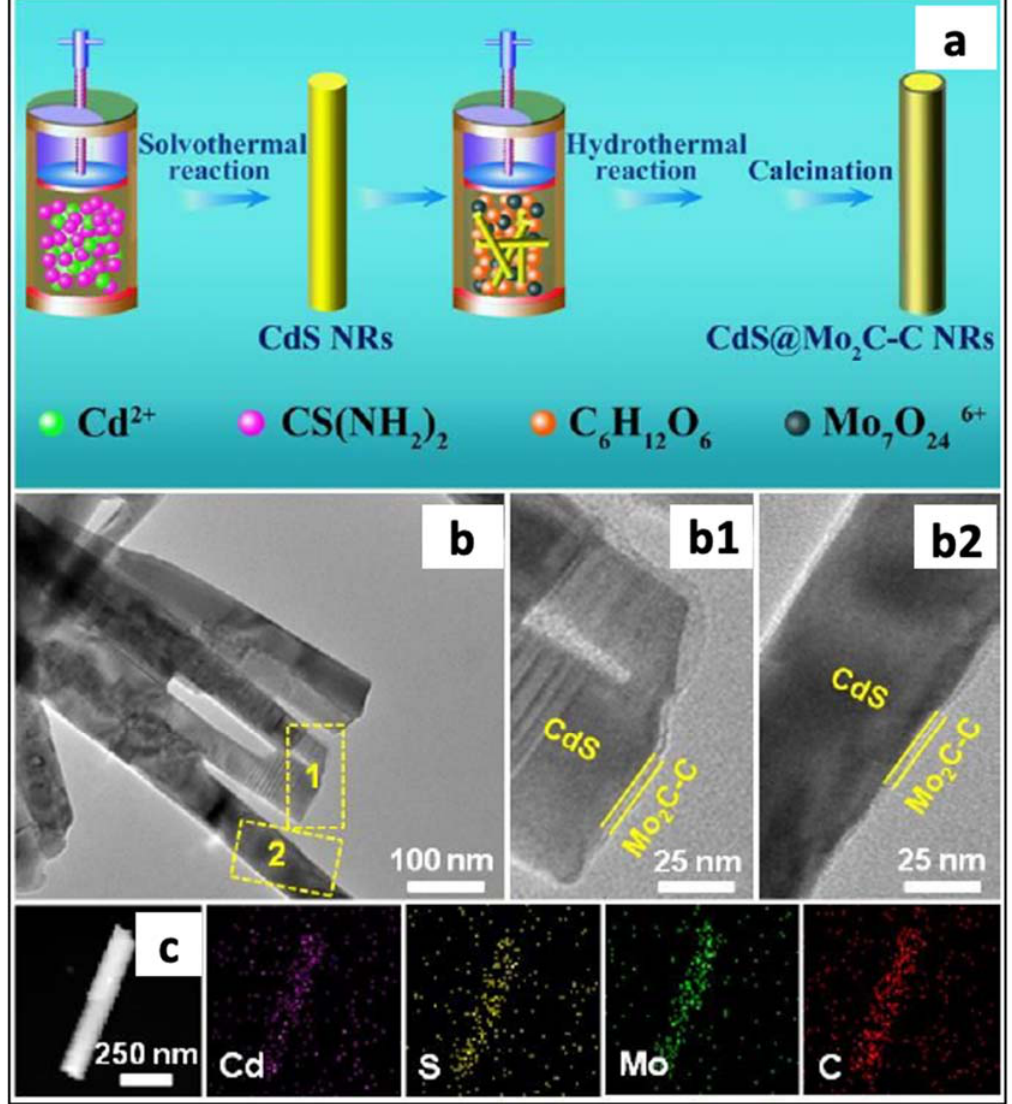
Figure 18. ( a ) Scheme illustration of the preparation process for CdS@Mo 2 C-C core-shell nanorods. ( b ) TEM images of CdS@1Mo 2 C-C core-shell nanorods; ( b1 , b2 ) the enlarged view of the circles areas in b; and ( c ) STEM-EDX elemental mapping for CdS@1Mo 2 C-C core-shell nanorods. Reproduced with permission from reference [135].